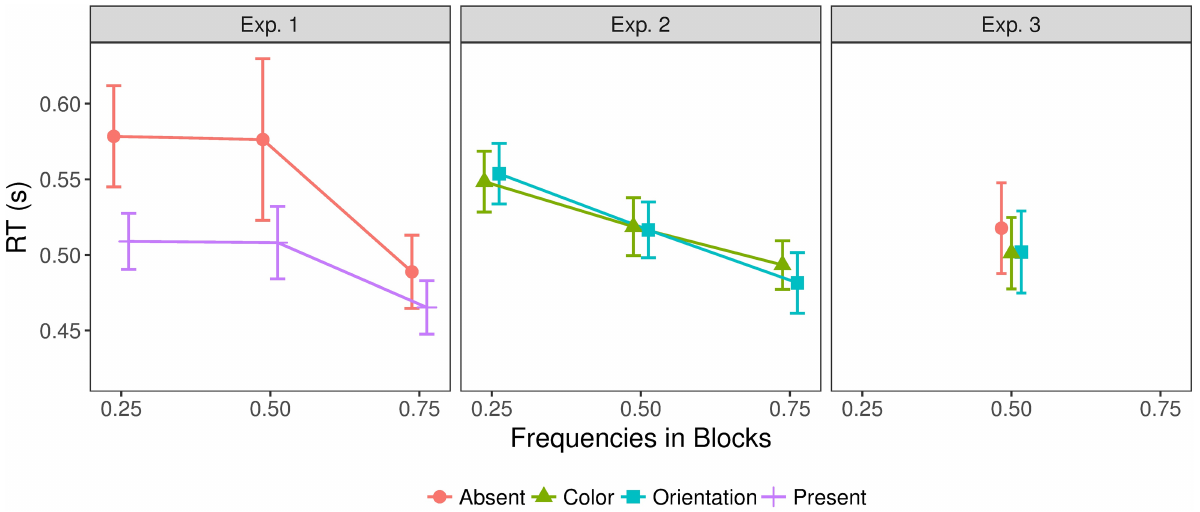
Fig 3. Mean RTs in Experiments 1, 2, and 3, for all combinations of target condition and target frequency. Target frequency is defined relative to the target condition, as the frequency with which that target condition occurred within a given block. This means that for a given frequency, the data from the different target conditions do not necessarily come from the same block of the experiment. Error bars show the standard error of the mean.